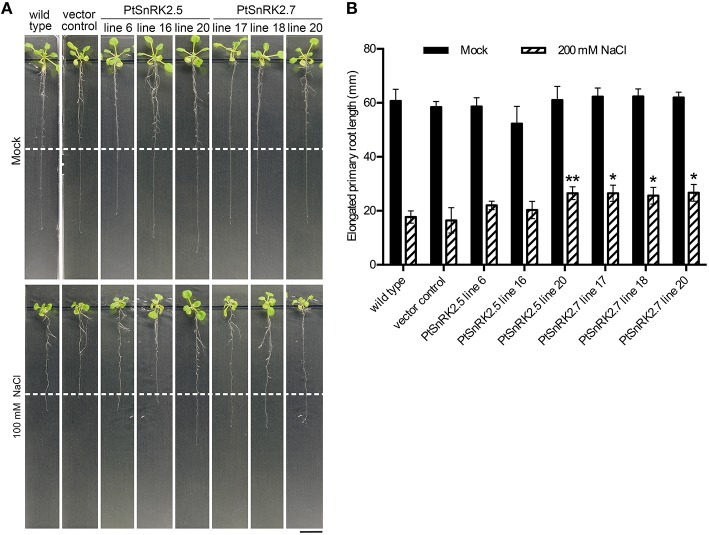
Primary root elongation of transgenic Arabidopsis overexpressing PtSnRK2.5 and PtSnRK2.7 during salt treatment. (A) Seedlings of the wild-type, vector control, and overexpressors of PtSnRK2.5 and PtSnRK2.7 treated with 100 mM NaCl for 5 days. The positions of the edges of the root tips before salt treatment are indicated by the white dotted lines. Bar = 20 mm. (B) Increase in root length after salt stress treatment. Results are means ± SE (n = 15). Asterisks indicate statistically significant differences between transgenic plants and the wild-type (Student's t-test; *p < 0.05; **p < 0.01).